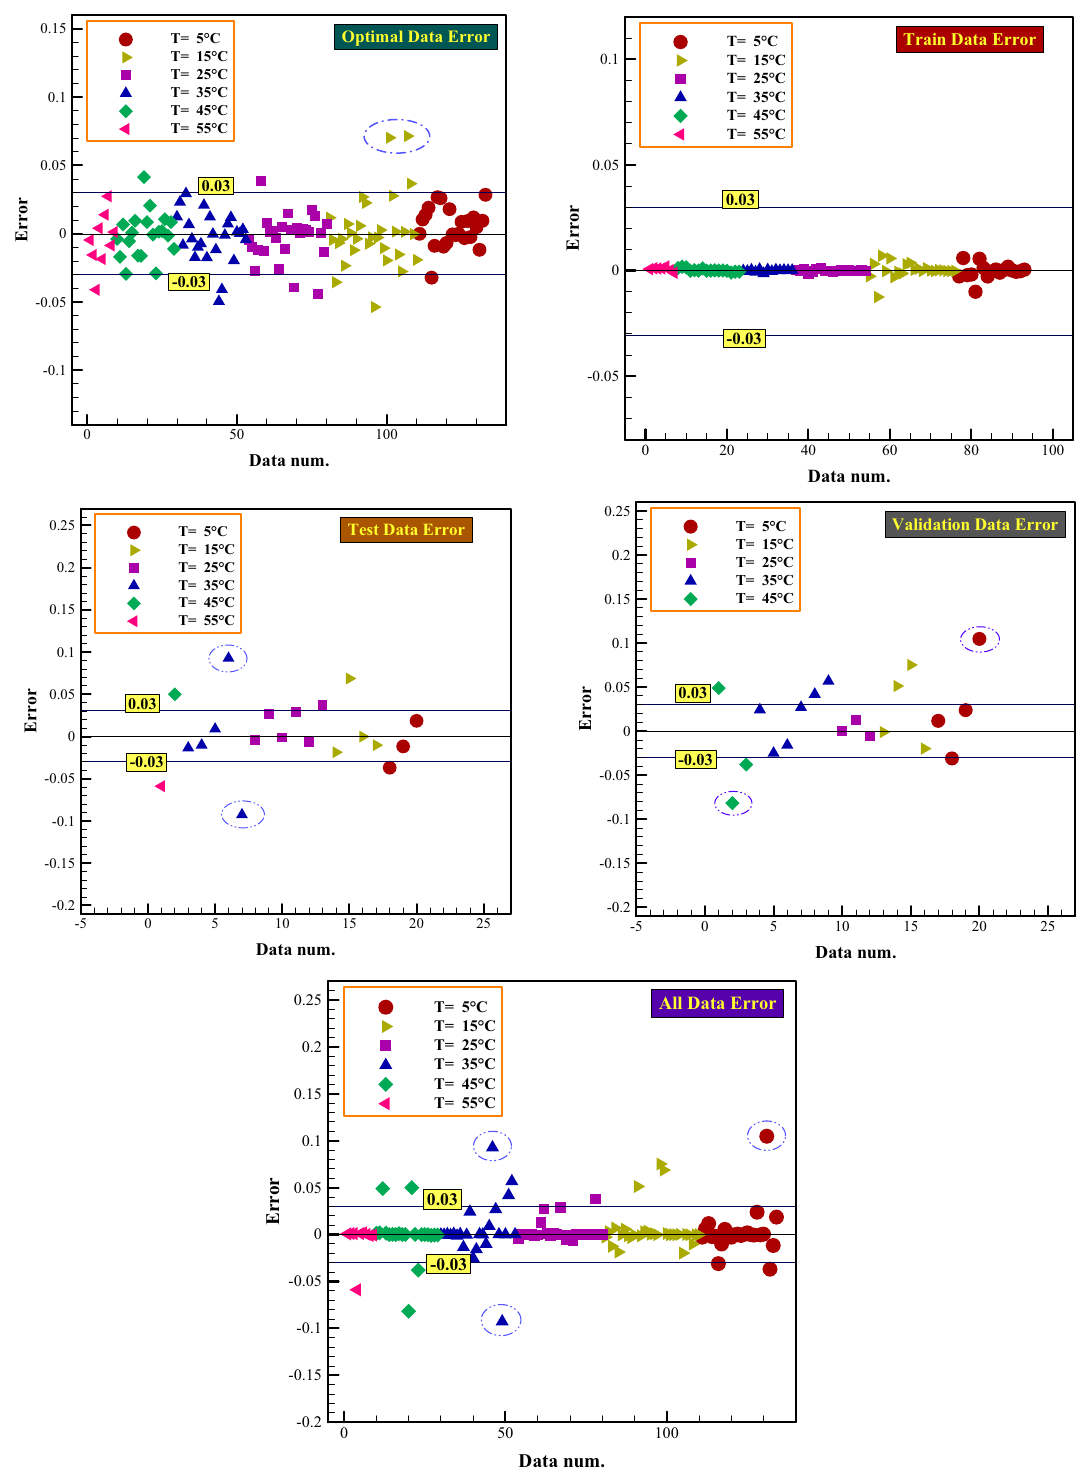
Figure 7. Calculated error